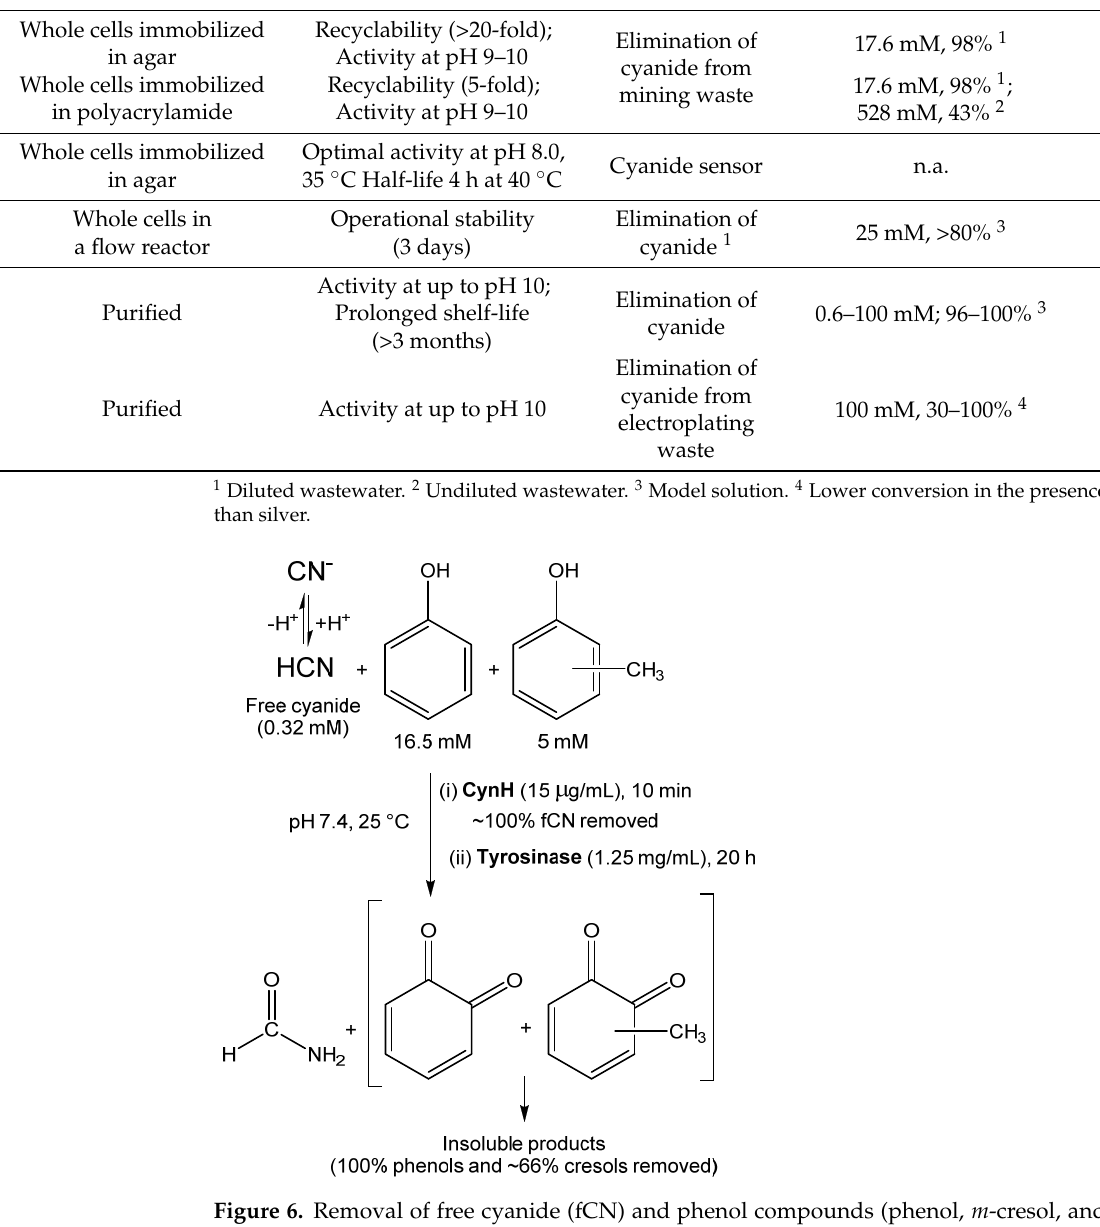
Figure 7. Removal of free cyanide (depicted as HCN) in model or diluted real electroplating wastewaters by cyanide hydratases (CynHs) overproduced in Escherichia coli . ( a ) The model wastewater was 100 mM glycine/NaOH buffer at pH = 9.0, supplemented with 100 mM KCN and 1 mM of AgNO 3 or 1 mM CuSO 4 . Conversion of HCN was catalyzed by the purified CynH from Exidia glandulosa [30]. ( b ) An electroplating bath wastewater with ca. 1 M fCN was 10 times diluted with 1 M MOPS buffer at pH = 8.0. Conversion of HCN was catalyzed by the purified CynH from Neuro- spora crassa [27]. The Cu or Ag content was not specified. r.t., room temperature. Studies on the immobilization of CynDs or CynDs are very few (Table 6). The whole cells of E. coli producing CynD pum were entrapped in agar or polyacrylamide and tested on a real mining effluent diluted to 17.6 mM fCN (Figure 8). Both catalysts almost com- pletely degraded 5 mM fCN after 2 h. Moreover, the agar-immobilized catalyst could be reused many times (with 91% and 60% fCN conversion at cycles 22 and 30, respectively). In contrast, the cells immobilized with polyacrylamide showed lower operational stability (the conversion decreased rapidly after about five runs). Both were much more active than the free whole cells at pH = 9.0 and also retained almost full activity at pH = 10.0, where the free whole cells were virtually inactive [62]. This suggests that adopting immobiliza- tion to protect the enzyme from the bulk medium is a useful alternative to the much more laborious mutations.